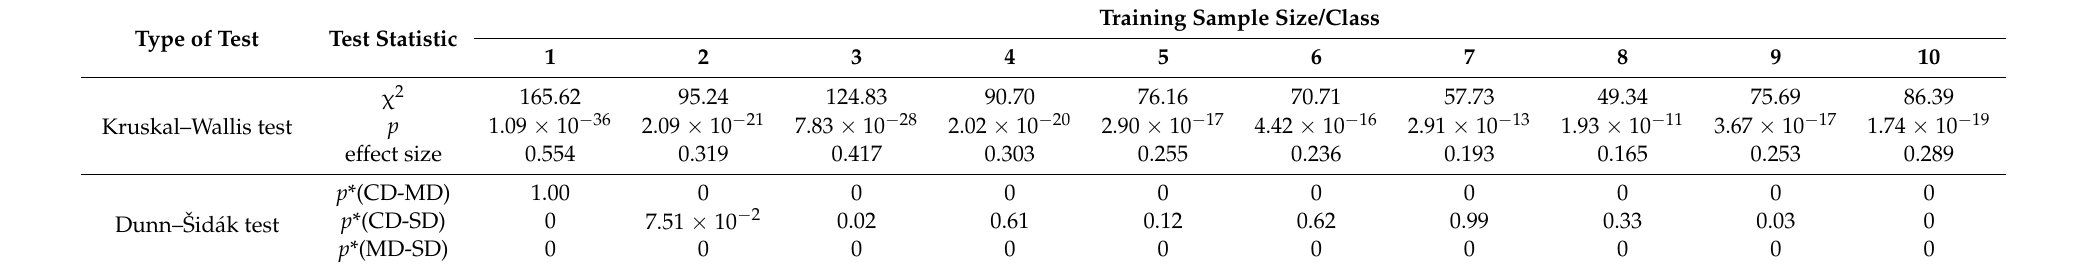
Table A2. Results of Kruskal–Wallis test and Dunn–Šidak post hoc test for naïve Bayes algorithm ( α = 0.05).